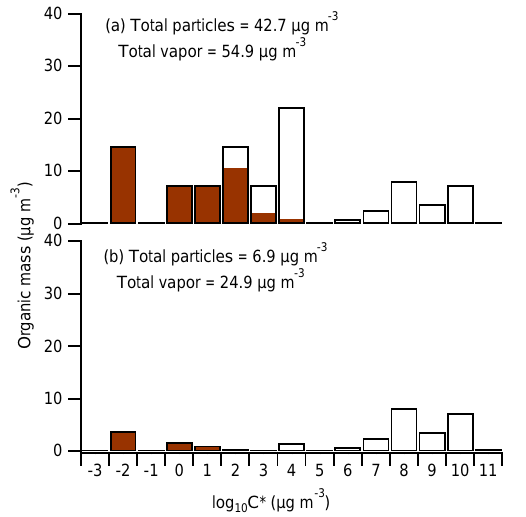
Figure 1. (a) Volatility distribution with 15 volatility bins, adapted from the work of May et al. (2013) and Hatch et al. (2017). The av- erage total initial organic aerosol mass concentration is 42.7µgm − 3 over the 18 experiments. For this mass concentration, the shaded area represents the organic mass in the particulate phase in each volatility bin. (b) The simulated volatility distribution without chemistry after 4h of particle and vapor wall loss. The concentra- tions are the means across all 18